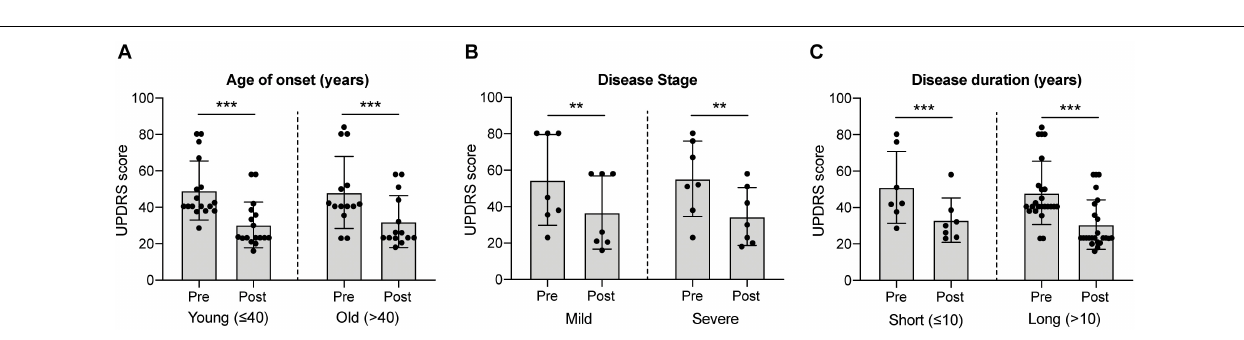
FIGURE 2 | Systematic analysis of various factors associated with clinical outcome in fVM cell transplantation in PD patients using UPDRS motor scores. Statistical comparison was performed on varying parameters against the Unified Parkinson Disease Rating Scale (UPDRS) motor scores of pre- and post-transplantation. (A) Age on onset: old ( > 40 years) vs. young ( ≤ 40 years) PD patients. (B) Disease stage in severe vs. mild condition. (C) Disease duration: long ( > 10 years) vs. short ( ≤ 10 years). Two-way ANOVA, Sidak’s multiple comparisons test, ** p < 0.005, *** p <